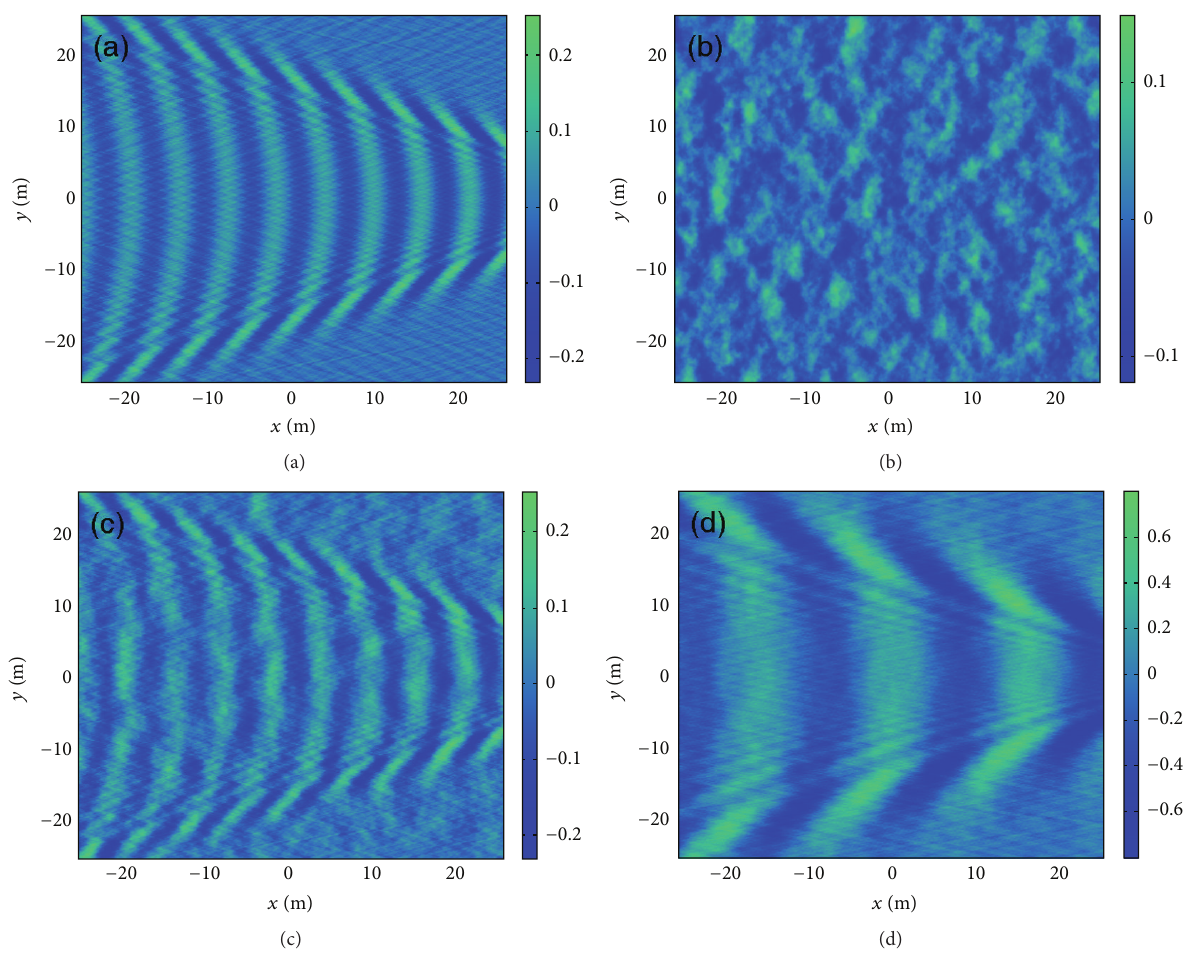
Figure 1: Simulated ship-induced Kelvin wake, wind-generated sea surface, and wind-generated sea surface with ship-induced Kelvin wake. (a) Ship wake only with ship speed 𝑈 𝑠 = 3 m/s, (b) sea surface only with wind speed 𝑈 10 = 3 m/s, (c) ship-induced wake embedded in sea with 𝑈 10 = 3 m/s and 𝑈 𝑠 = 3 m/s, and (d) ship-induced wake embedded in sea with 𝑈 10 = 3 m/s and 𝑈 𝑠 = 5 m/s. The unit of the color bar is